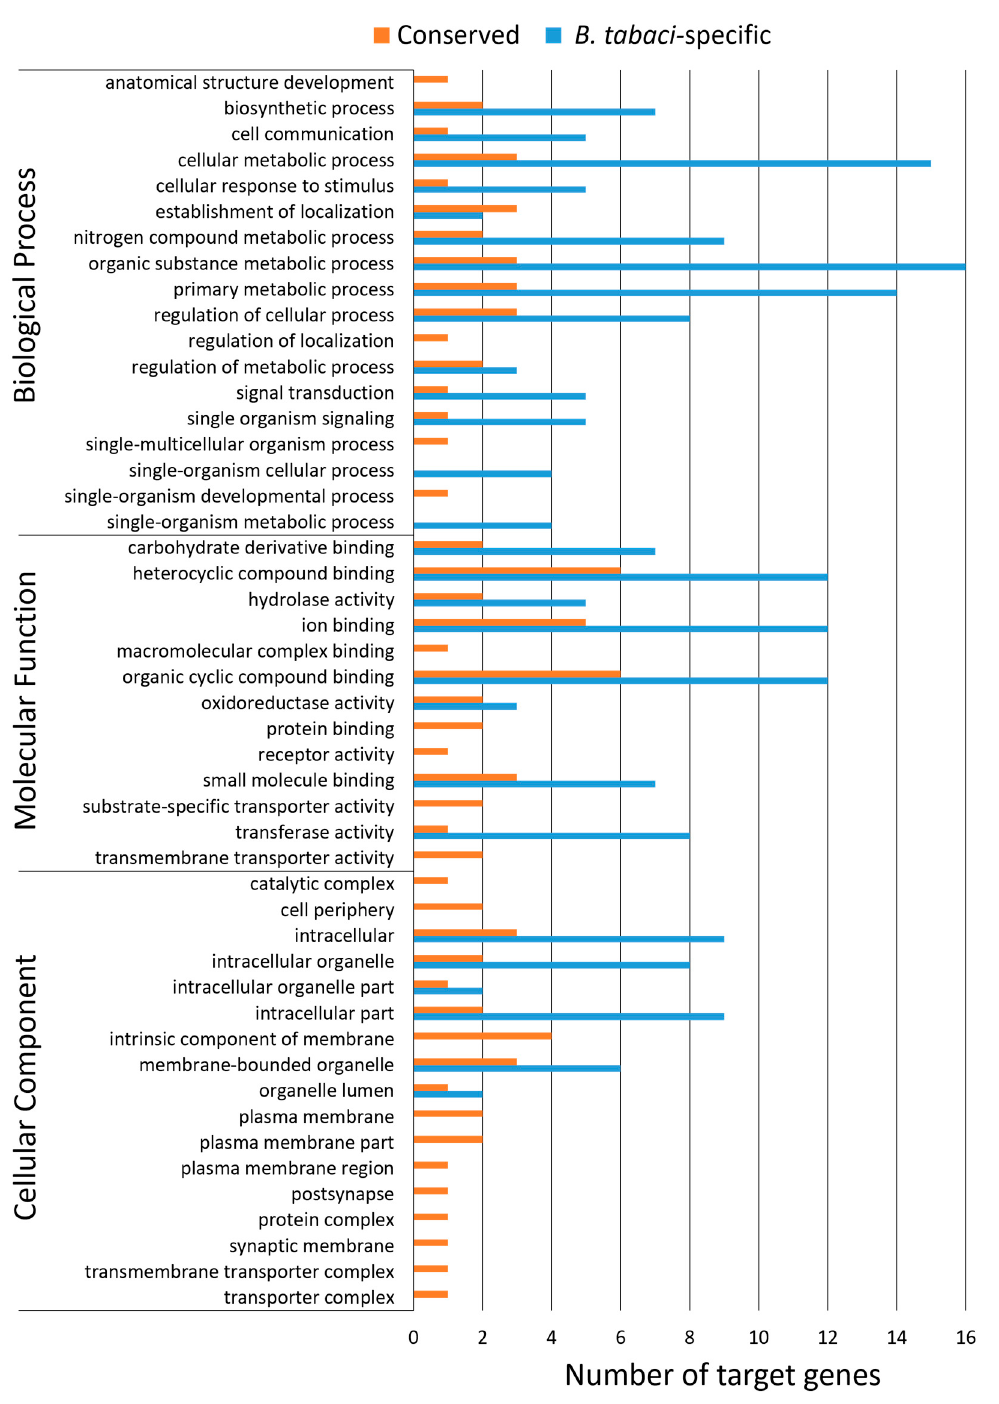
Figure 2. Overview of gene ontology for single gene targets of miRNAs. Functional classification of all 160 miRNAs. Number of conserved (orange) and B. tabaci -specific (blue) miRNAs assigned to each ontology. Gene ontology terms of level 2 are shown.